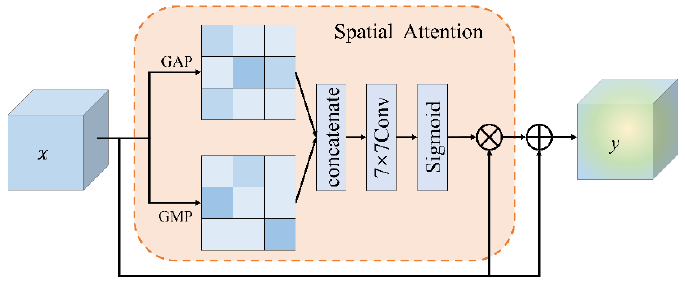
Figure 2. The structure of the spatial attention unit.